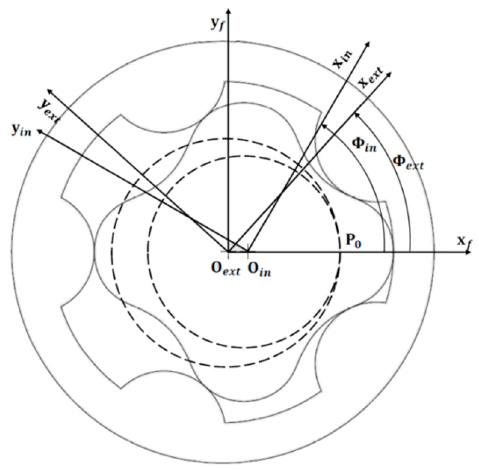
Figure 2. Reference systems for gerotor design.